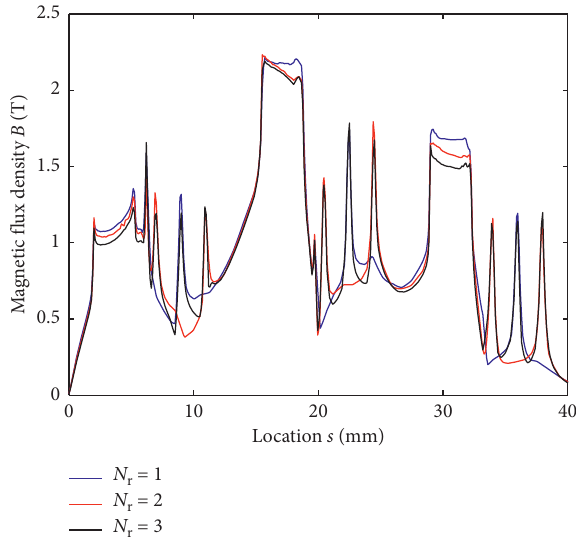
Figure 9: Magnetic field distribution with different teeth number in the radial sealing position. N r : radial